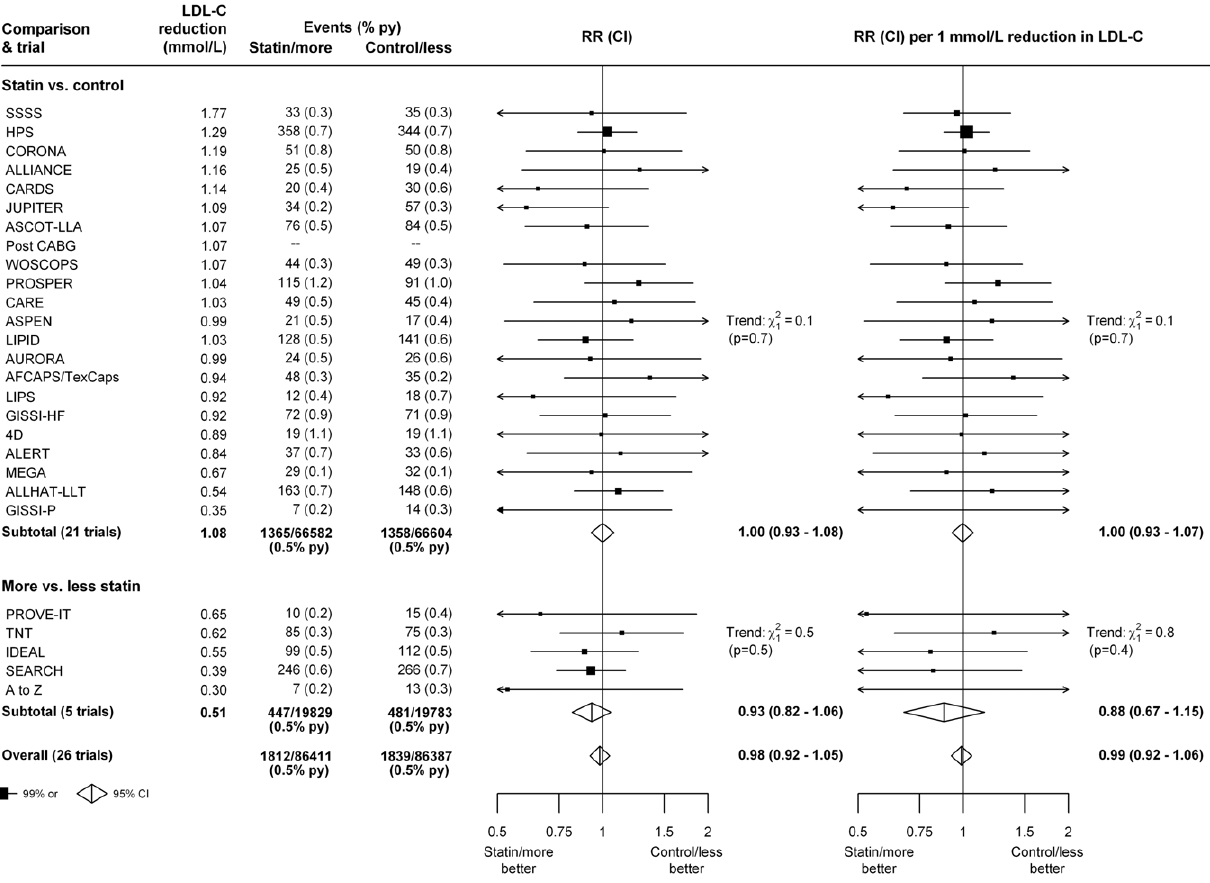
Figure 2. Effects of statin therapy on cancer mortality in each study. Symbols and conventions as in Figure 1. Deaths from cancers known to have been first diagnosed prior to randomization are excluded.